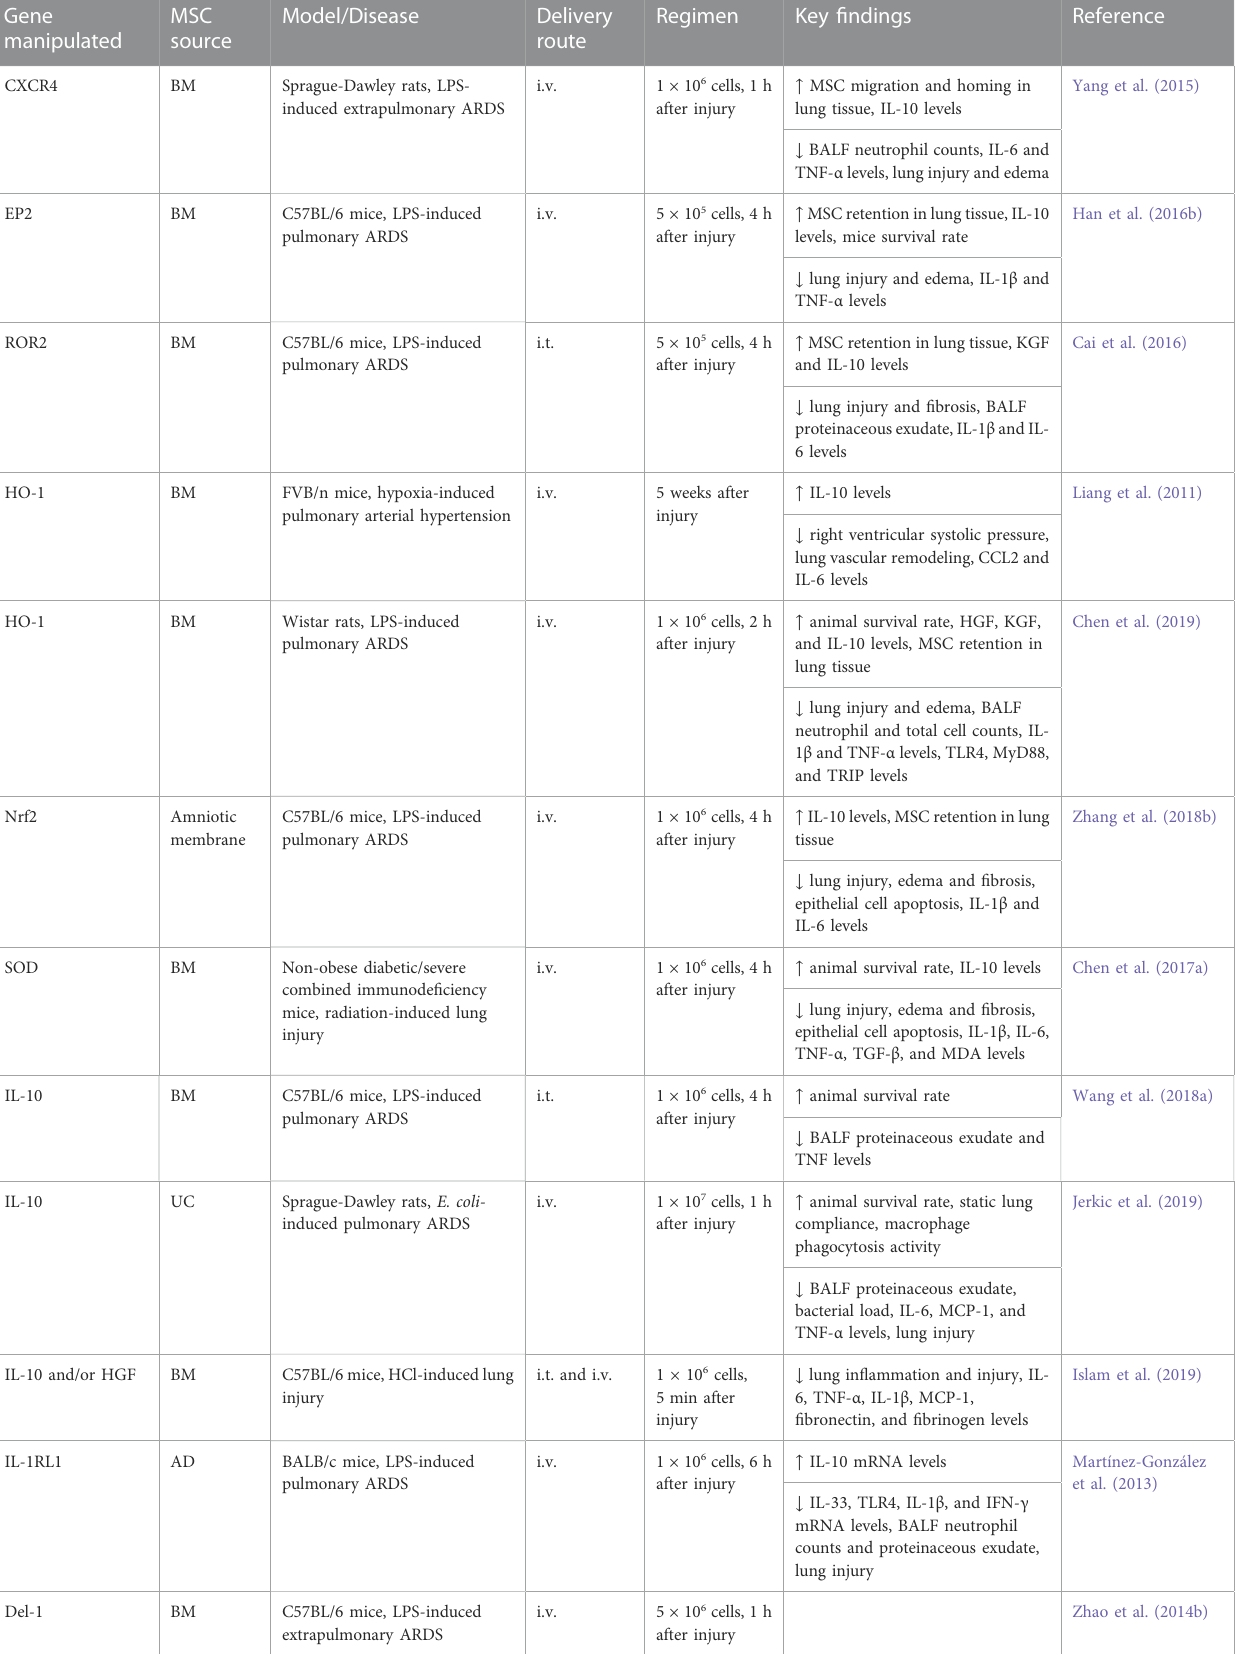
TABLE 4 In vivo preclinical studies assessing the ef fi cacy of genetically engineered